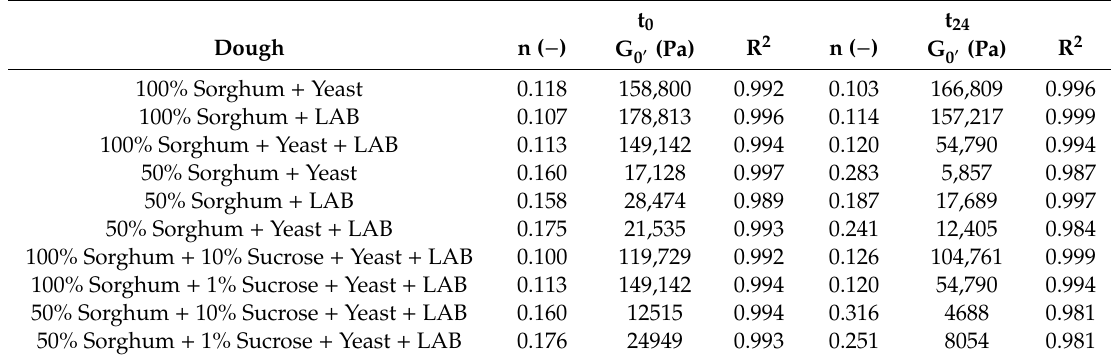
Table 4. Linear regression parameters (n and G (cid:48) 0 ) from application of the power law model (2) of elastic modulus G (cid:48) curves. R 2 : linear regression coe ffi